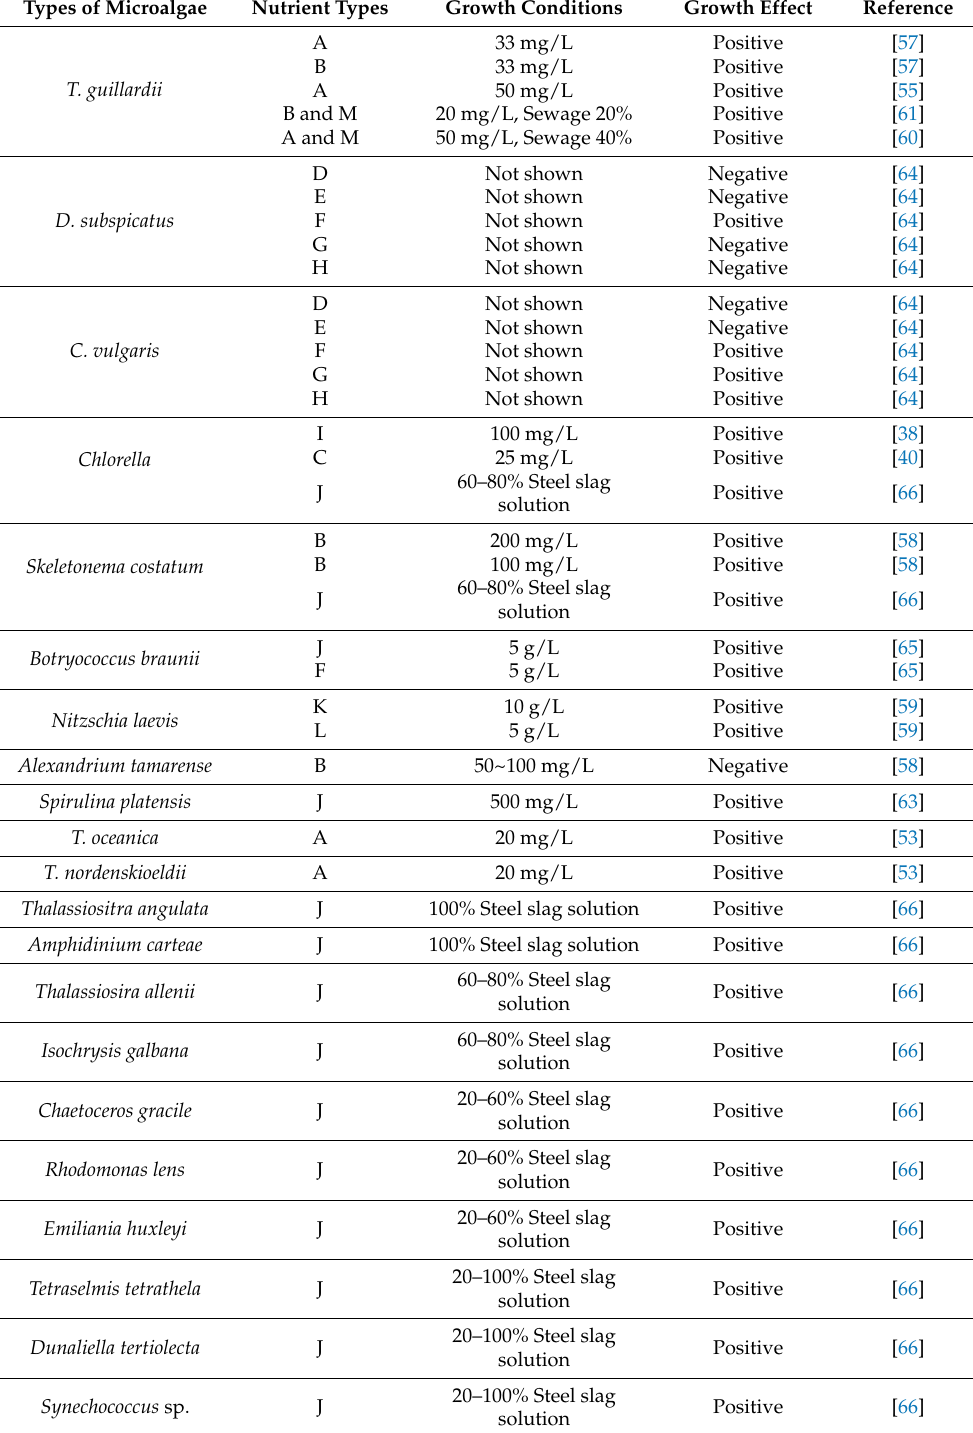
Table 2. The influence of steel slag on the growth of